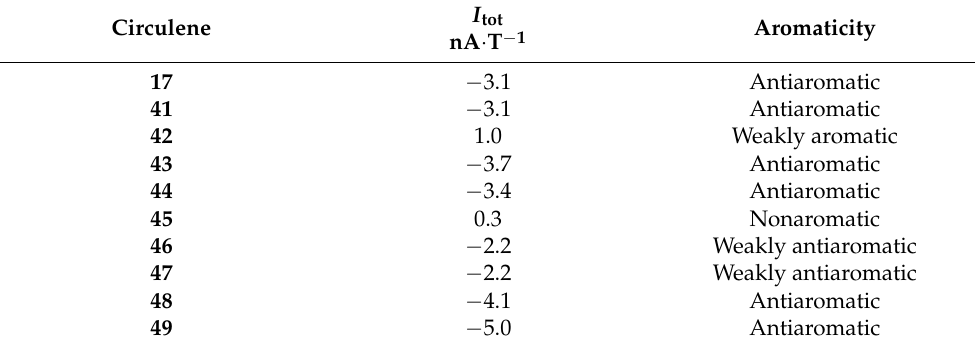
Table 4. The total ring current strength ( I tot ) and aromaticity of the azatrioxa[8]circulene molecules. I tot Circulene nA · T − 1